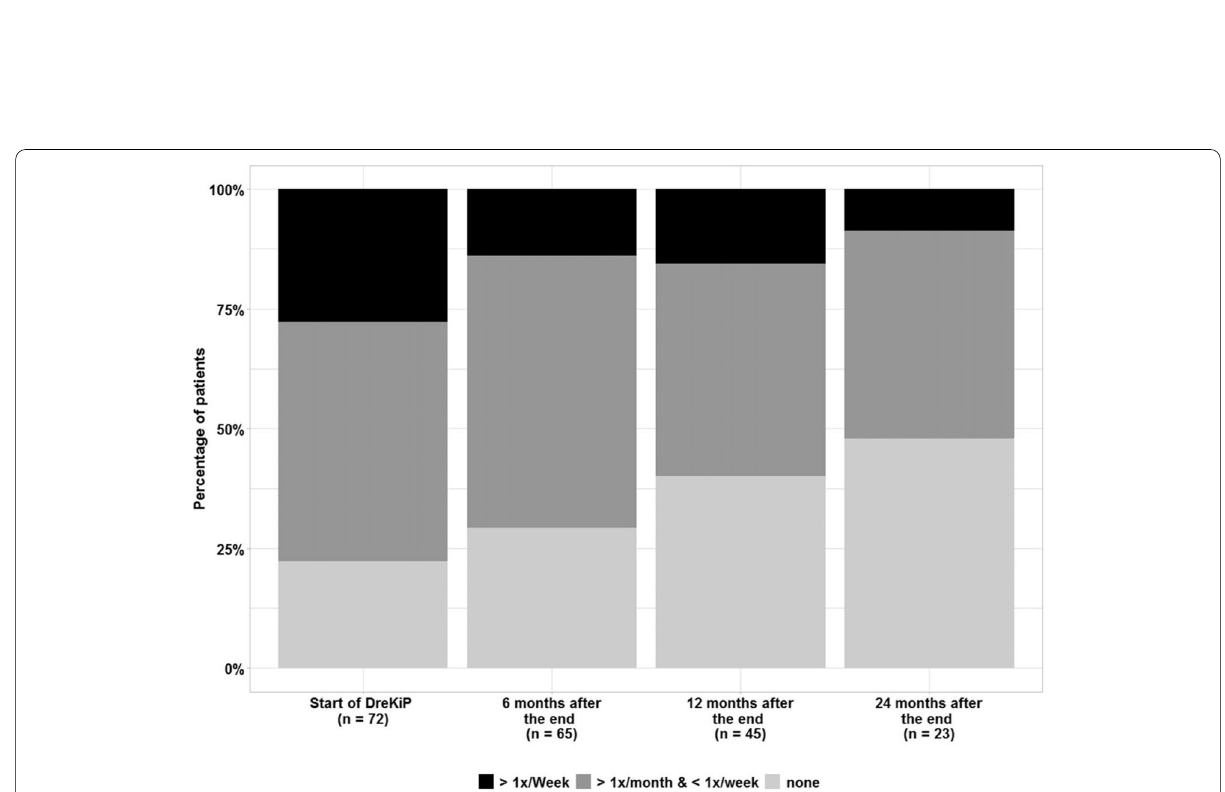
Fig. 5 Acute Headache Medication intake at baseline and follow up, 6, 12 and 24 months after the